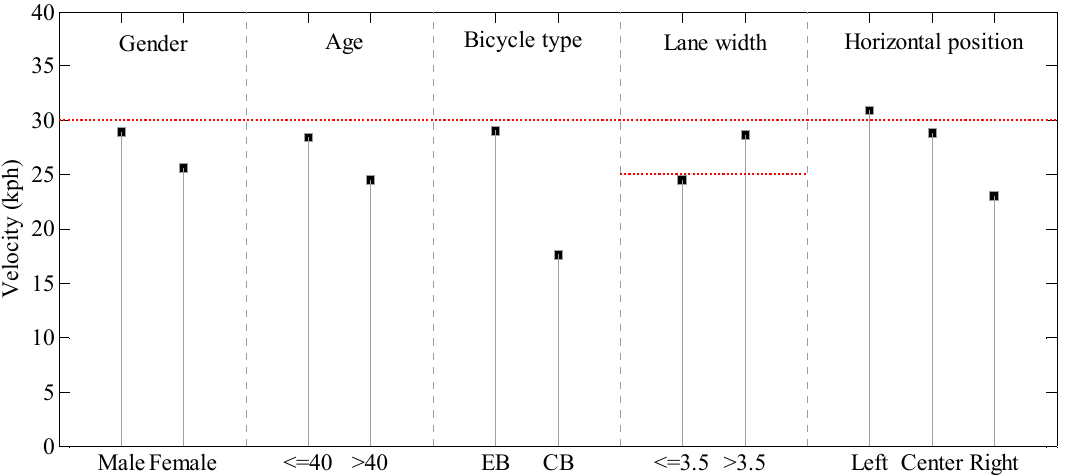
Table 7. Velocity Statistics by Gender, Age, Bicycle Type, Lane Width and Lateral Position. Factor